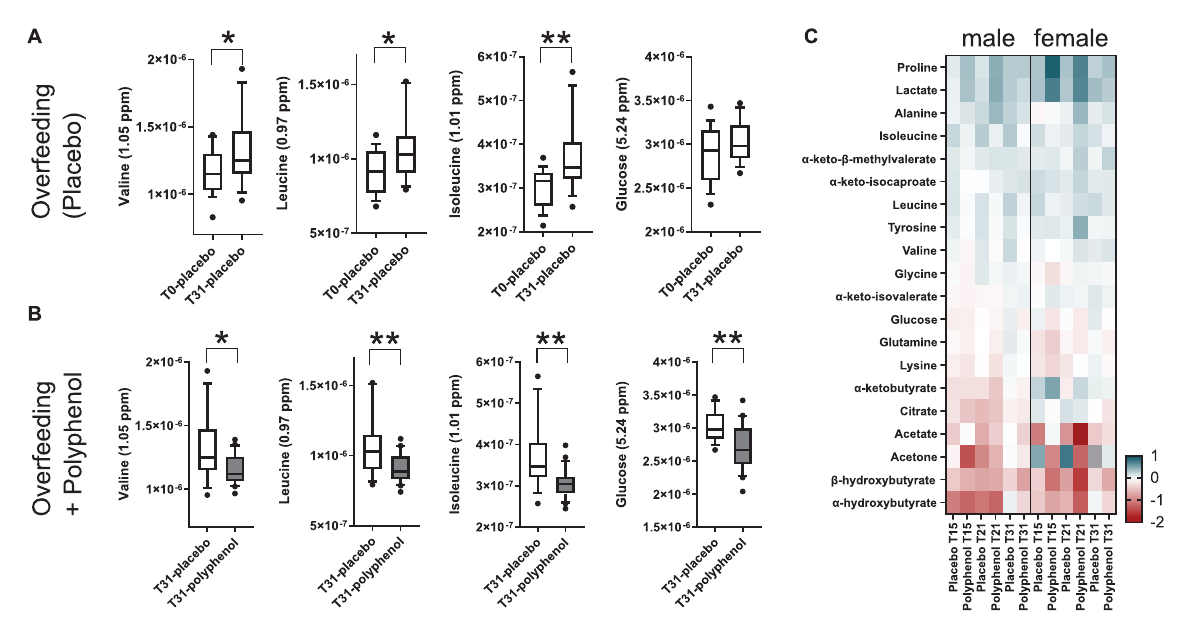
FIGURE3 Relative plasma metabolite concentrations of highlighted metabolites during an overfeeding and polyphenol clinical interventions for the male “Lyon” study (A–C) and the female “Lausanne” study (C) . (A) Overfeeding (placebo arm) in males (Lyon study) leads to increased plasma concentrations of the BCAA valine, leucine and isoleucine and glucose. (B) A 31-day polyphenol administration in an overfeeding intervention (polyphenol arm) in males (Lyon study) leads to decreased plasma concentrations of the BCAA valine, leucine and isoleucine and glucose compared to the overfeeding arm. (C) Heatmap of log2 fold changes of plasma metabolite relative concentrations, adjusted per each individual’s baseline (T0), in the male (Lyon) and female (Lausanne) studies. T0, T15, T21, and T31 correspond to days 0, 15, 21, and 31 of the intervention; the NMR intensities relate to metabolite concentrations (arbitrary units); p -values obtained by t -test (* p -value ≤ 0.05, and ** p -value ≤